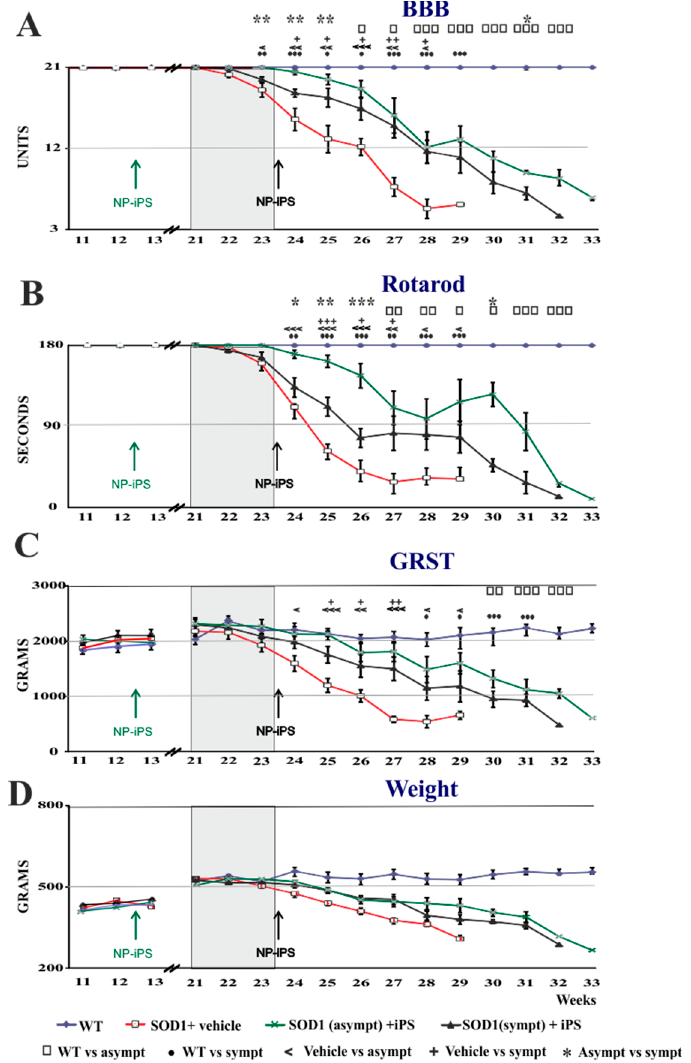
Figure 2. Intraspinal NP-iPS transplantation delays loss of motor function and prolongs the survival of SOD1 G93A transgenic rats. Human NP-iPS significantly delayed motor impairment evaluated by BBB- ( A ) and Rotarod-tests ( B ), and it slowed down loss of muscle strength assessed by the grip strength test ( C ) and demonstrated the tendency to protracted body weight loss compared with vehicle-treated littermates ( D ). Arrows depict time of cell injections into asymptomatic (green) and symptomatic (black) SOD1 G93A rats. Differences in the groups were analyzed by two-way ANOVA with repeated measures: statistical significance at p -values under 0.05 (*, □ , ● , <, +), p < 0.01 (**, □□ , ●● , <<, ++) and p < 0.001 (***, □□□ , ●●● , <<<, +++). □ WT vs. asympt, ● WT vs. sympt, < vehicle vs. asympt, +vehicle vs. sympt, * asympt vs. sympt. A detailed statistical analysis of the behavioral changes between the groups is presented in Tables A1 and A2.